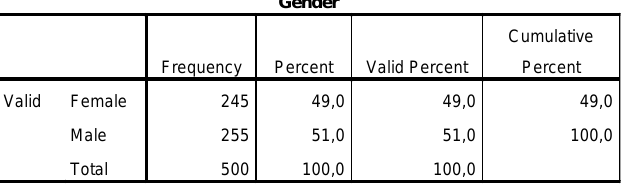
Table 2: Gender Distribution